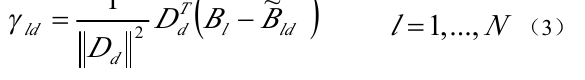
Figure 3 is flow chart of the improved high frequency modified fusion method.